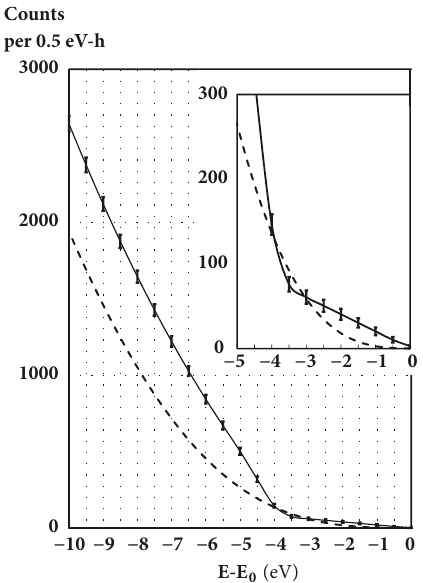
Figure 9: Simulated KATRIN data based on the 3+3 model masses for the last 10 eV of the spectrum as it appeared in [18]. The error bars are based on statistical uncertainties for one hour of data-taking for each of 24 energy bins of 0.5 eV width, with the event count normalized to yield the expected count rate at 𝐸 0 − 𝐸 = 20 eV. The dashed curve shows all 𝑚 𝑗 = 0 case after final state distributions and energy resolution have been included. The insert shows the last 5 eV with an expanded vertical